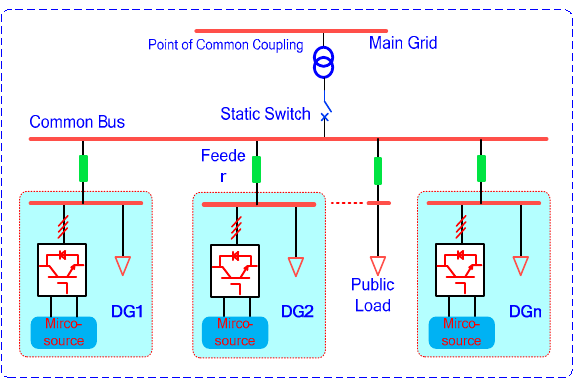
Figure 1. A simplified schematic of the microgrid.